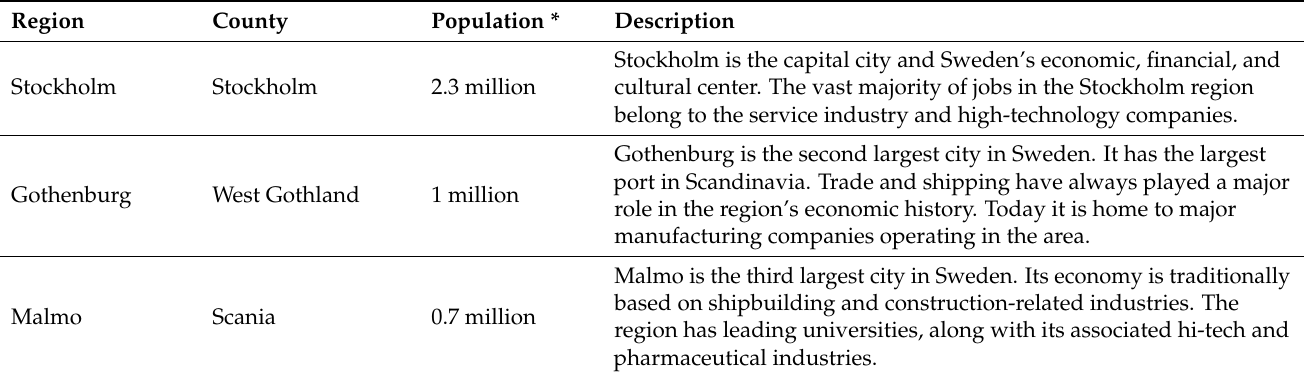
Figure 2. Three largest urban regions in Sweden. Table 1. Socio-economic description of the three largest urban regions in Sweden.